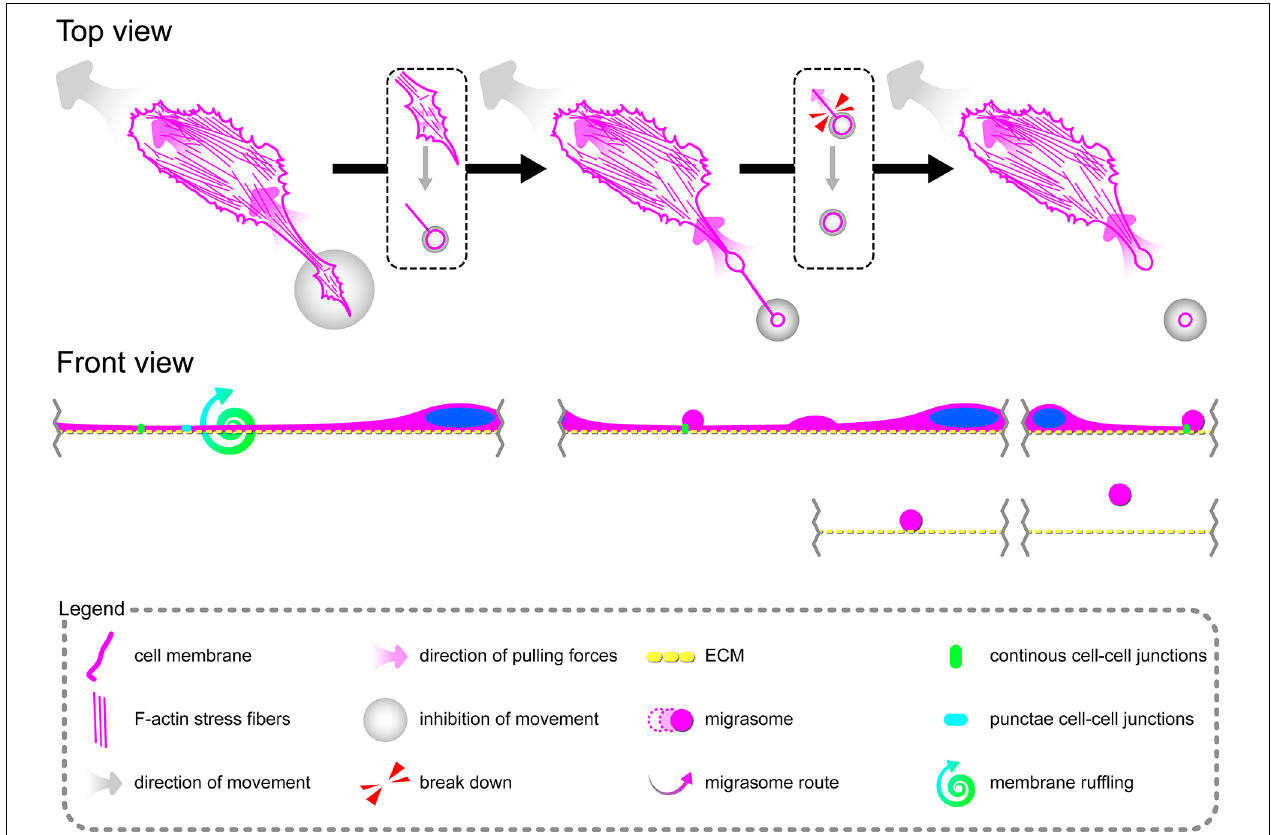
FIGURE 10 | Schematic overview of TNF α -induced formation of migrasomes and migracytosis in